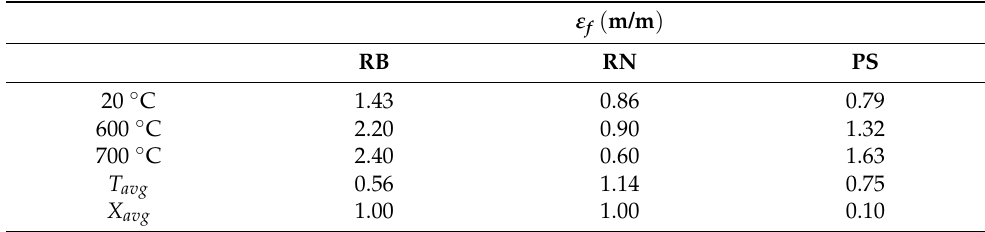
Table 9. Triaxiality,Lodeparameter,andequivalentplasticstrainatfracturefordifferenttestsandtemperatures.